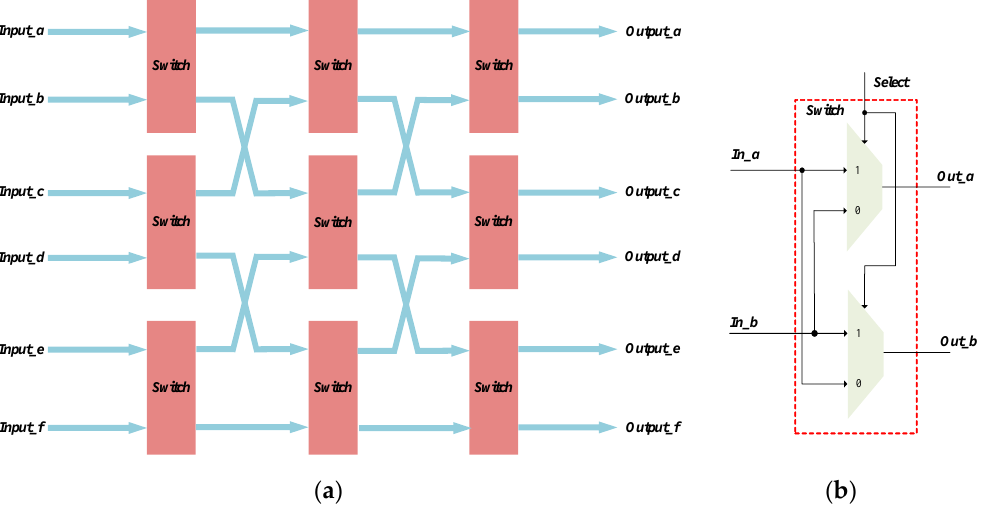
Figure 6. Principle of address routing. ( a ) Address routing structure. ( b ) Switch